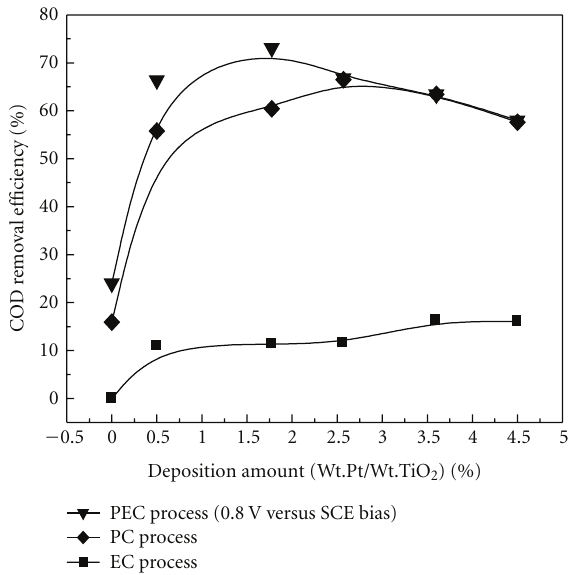
Figure 7: Dependence of COD removal e ffi ciency on deposited Pt amount.